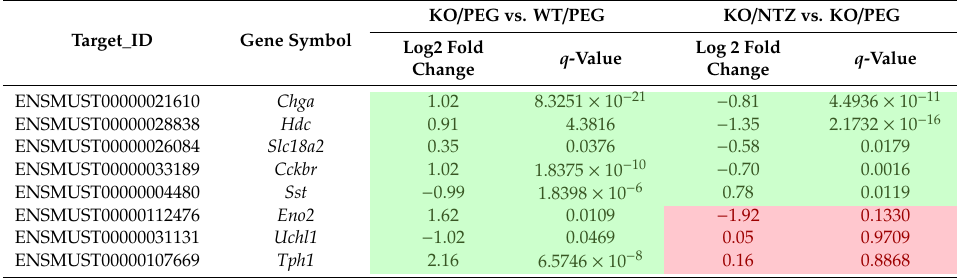
Table 3. Expression of NE markers in gastric corpus mucosa of WT / PEG versus KO / PEG mice and KO / NTZ versus KO / PEG mice. General NE and ECL cell markers were overexpressed in KO mice and downregulated by NTZ. Green: significant change (adjusted p-value ( q -value) < 0.05); red: non-significant change ( q -value >